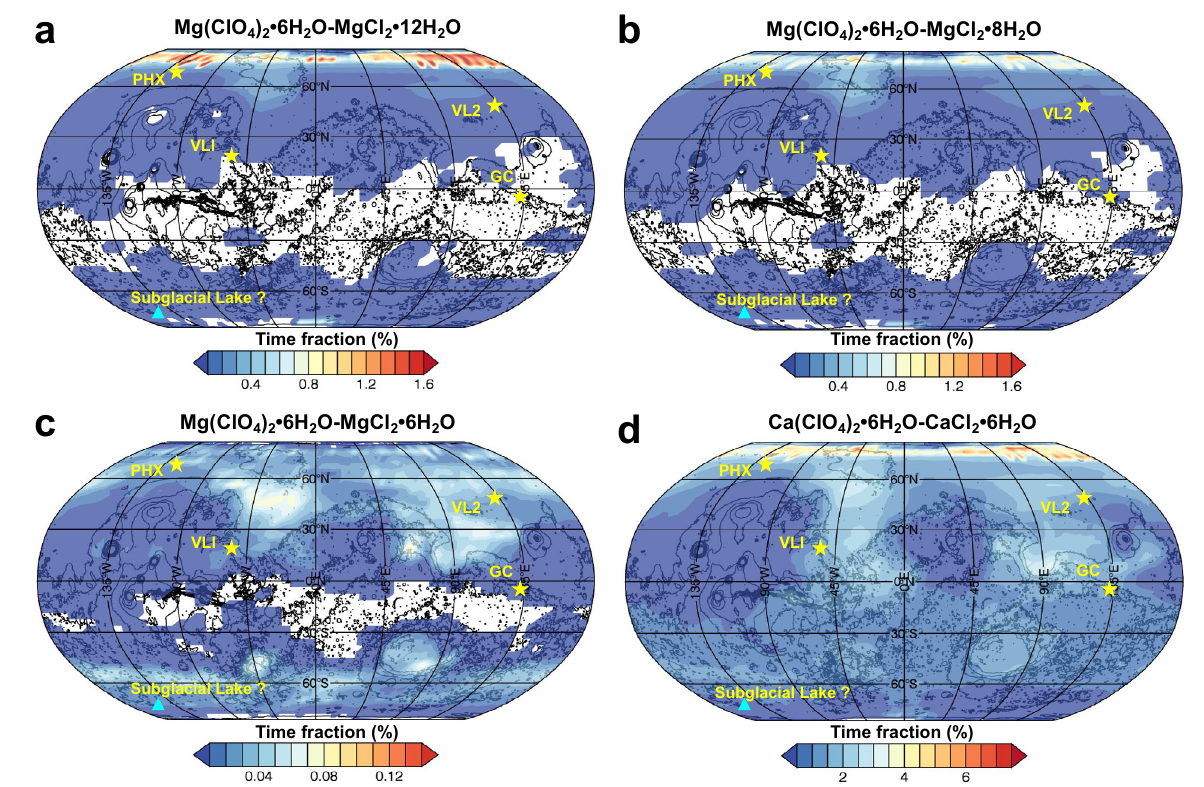
Fig. 4 Time fraction of a Mars year under the present climate where surface RH -T conditions can support ClO 4 − /Cl − fractionation for Mg- or Ca- perchlorate-chloride salt mixtures. a – c are for the Mg-salt mixture, with the hydrated state of Mg-chloride varying from 12H 2 O, 8H 2 O, and 6H 2 O, respectively. d is for Ca(ClO 4 ) 2 (cid:129) 6H 2 O-CaCl 2 (cid:129) 6H 2 O. A ClO 4 − /Cl total molar ratio >0.2 is used as the indicator of perchlorate/chloride fractionation and the corresponding boundary conditions for each salt mixture are shown in Supplementary Fig. 19 and Supplementary Table 7. PHX represents the Phoenix landing site; VL1 and VL2 represent Viking Landers 1 and 2, respectively; GC represents the Gale Crater. Regions without colors indicate that the surface RH -T conditions would never support ClO 4 − /Cl − fractionation. Globally, the north polar region can maintain ClO 4 − /Cl − fractionation for the longest time with both Mg- and Ca- salt mixtures. Compared to the Phoenix site, Viking Landers 1 and 2 and Gale Crater are located in regions with a shorter time fraction. Dynamics of the water cycle and parental salts are critical controlling factors. See the text for